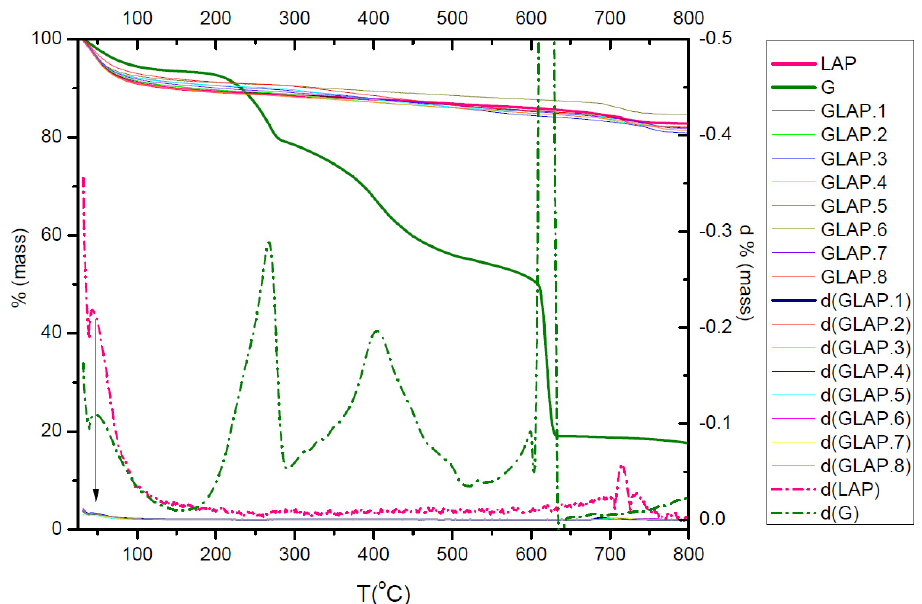
Figure 14. TGA–DTA diagram of laponite (LAP), chlorophyll (G) and the synthesized hybrid pigments GHA for the different conditions [1_8].